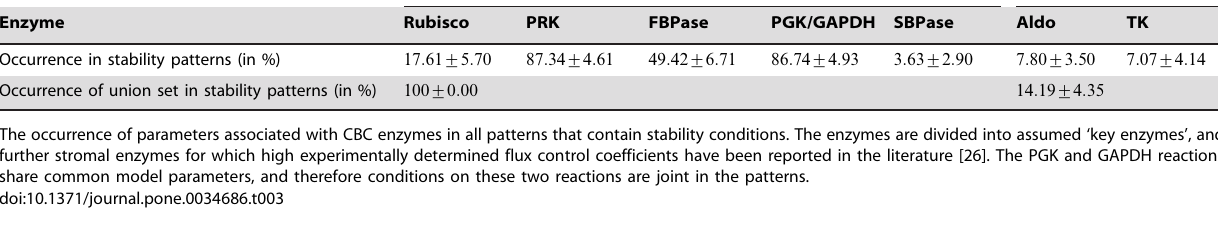
Assumed ‘key enzymes’ of the CBC Further CBC enzymes Enzyme Rubisco PRK FBPase PGK/GAPDH SBPase Aldo TK Occurrence in stability patterns (in %) Occurrence of union set in stability patterns (in %)